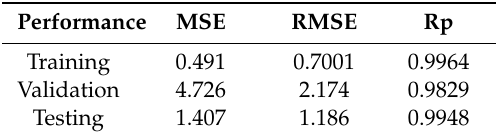
Table 10. Performance of the ANN model for the wet season.